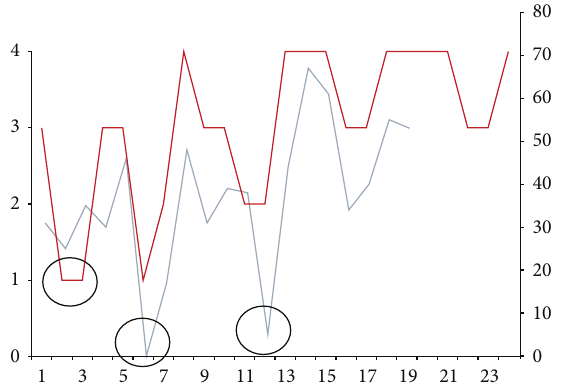
Figure 6: Chronology of implantations. Relationship between radiologic classification (red line) and AF values (blue line). Circles indicate cases of bad coupling. The 𝑦 -axis describes the radiologic classification Type IV to Type I and AF values in dB. The 𝑥 -axis describes the chronology of surgeries 1 to 24.